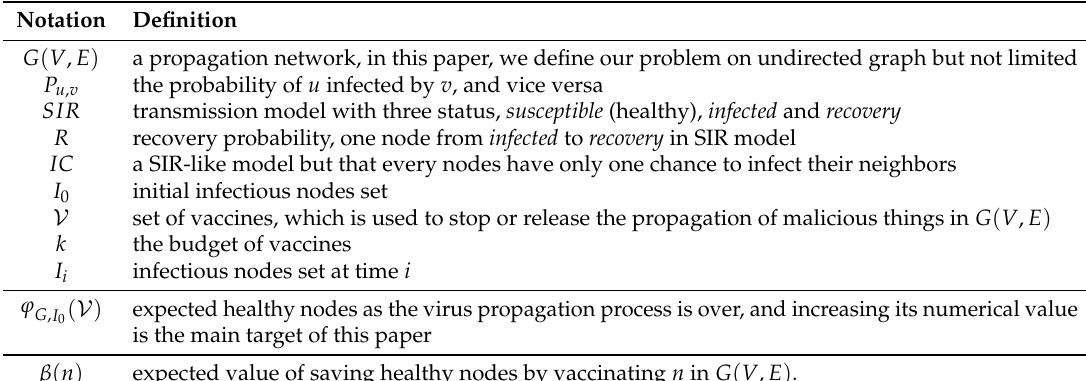
Table 1. List of